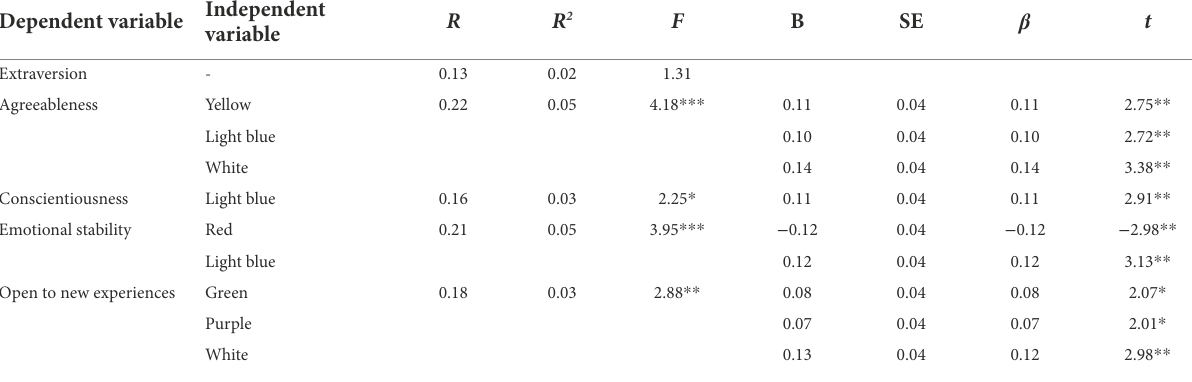
TABLE 4 The effect of color preference on big five personality trait.